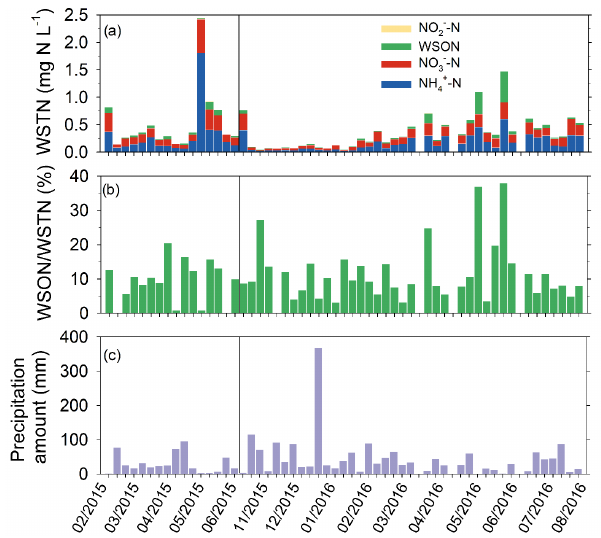
Figure 4. Concentrations of nitrogen species in weekly precipita- tion samples (a) , percentage contribution of WSON to WSTN in precipitation (b) , and precipitation amount (c) . The vertical line marks discontinuity due to missing data from 1 June to 19 Octo- ber